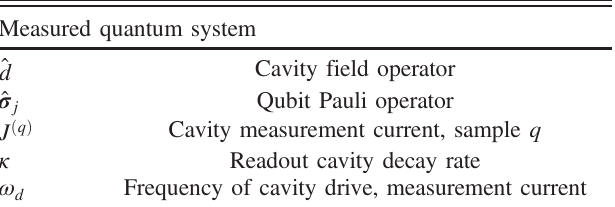
TABLE I. Descriptions of symbols, sorted by